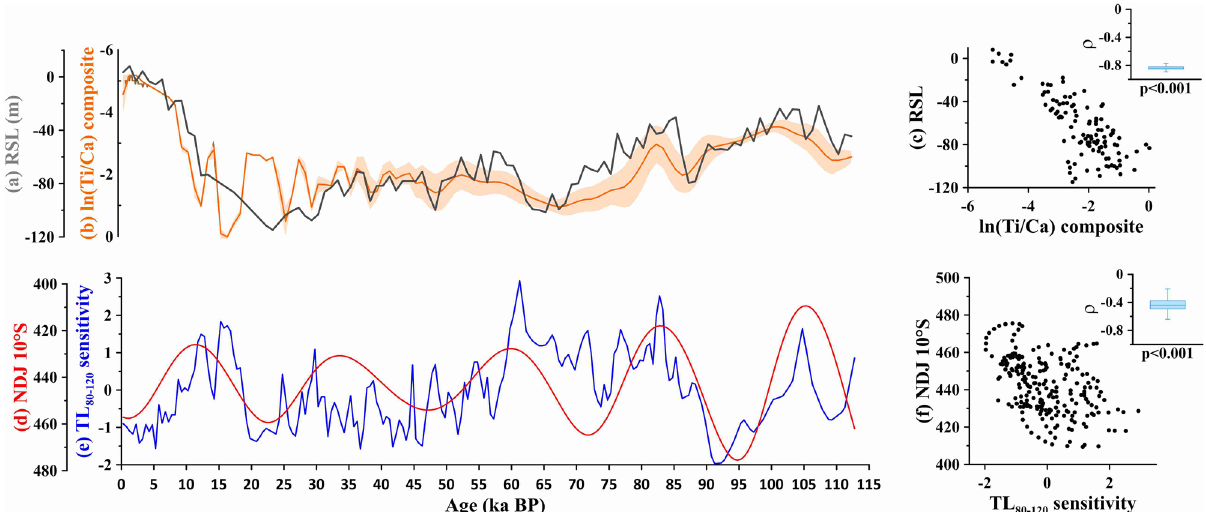
Figure 5. Northern NE Brazil (NEB) records and correlations with relative sea-level (RSL) and austral summer insolation. ( a ) RSL probability maximum (dark grey) 35 . ( b ) ln(Ti/Ca) composite record from marine sediment cores GL-1248 17 and GeoB16206-1 48 (orange curve) enveloped by standard deviation (orange shade). ( c ) Correlation between RSL record and ln(Ti/Ca) composite record (here we used the 500 year resolution chronological timeseries of the GL-1248 and GeoB16206-1 composite record described in Text S1). ( d ) November–January (NDJ) insolation (W/m 2 ) at 10°S 47 . ( e ) Thermoluminescence (TL 80–120 ) sensitivity of the 110 °C peak from marine sediment cores GL-1248 and GeoB16206-1 21 (this study). ( f ) Correlation between NDJ insolation at 10°S 47 and TL 80–120 sensitivity record from marine sediment cores GL-1248 and